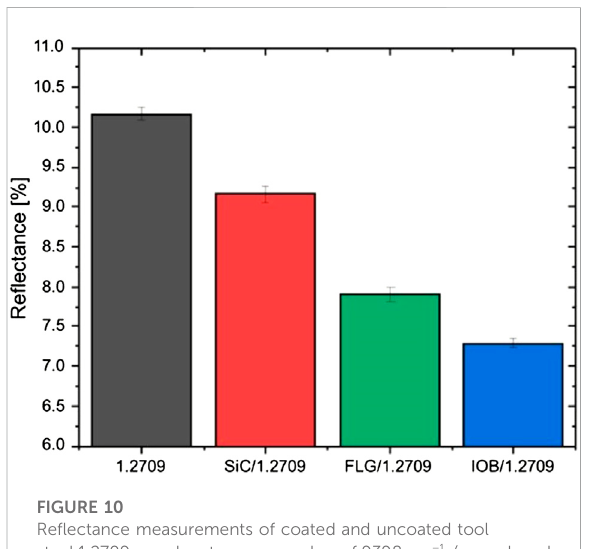
FIGURE 10 Re fl ectance measurements of coated and uncoated tool steel 1.2709 powder at a wavenumber of 9398 cm − 1 . (reproduced from Pannitz et al. (2021) under the CC BY 4.0